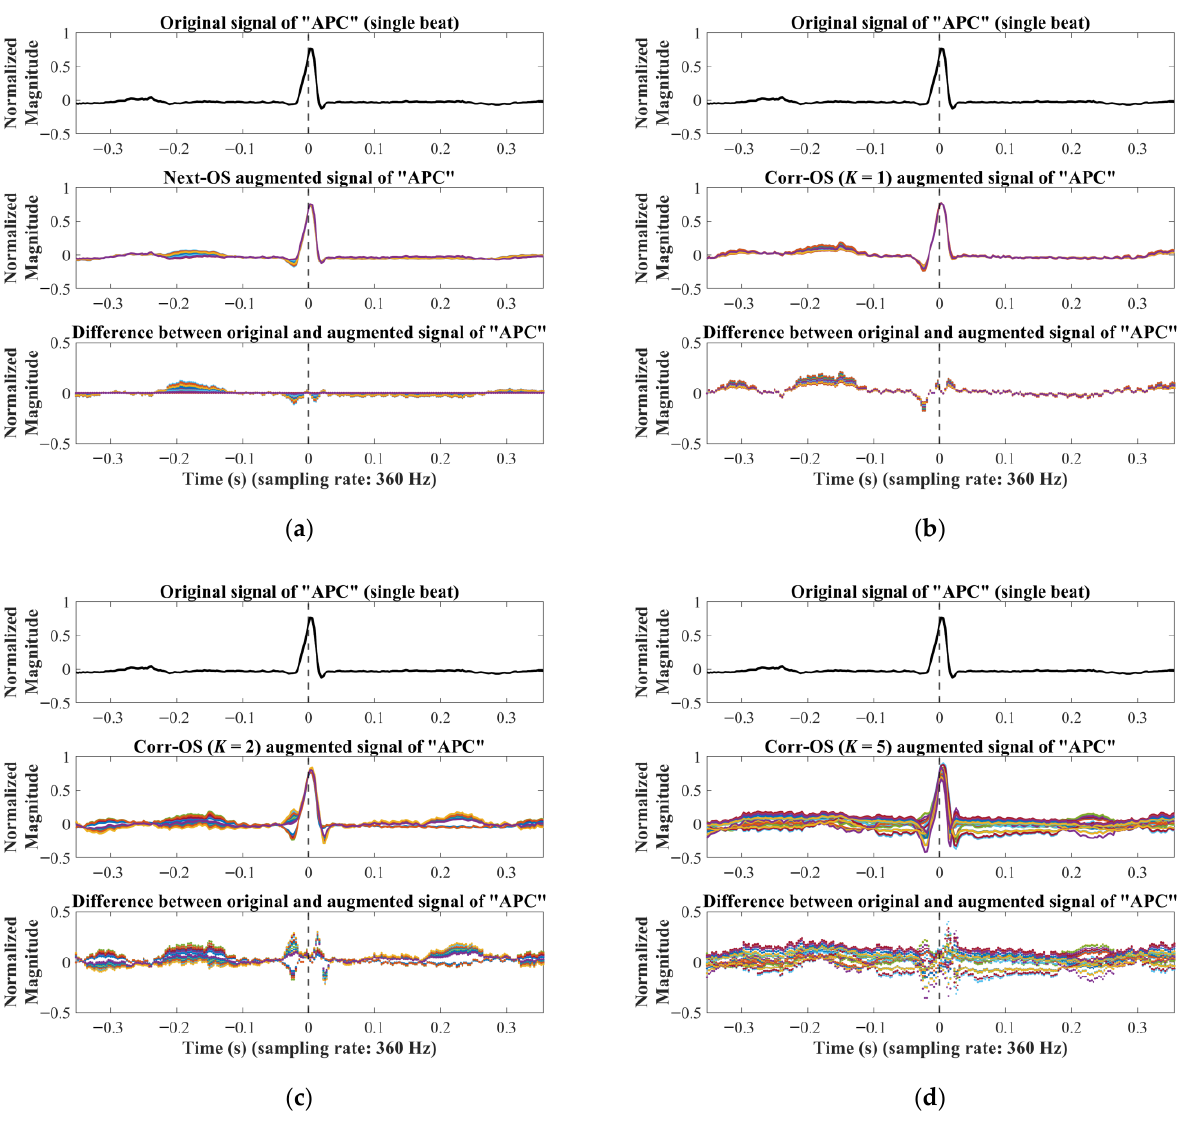
Figure 3. Differences between native and augmented ECG segments (symbol A, atrial premature beats) generated by the ( a ) Next-OS (next beat) and Corr-OS (top K correlation beats) algorithms with ( b ) K = 1, ( c ) K = 2, and ( d ) K = 5 (figure adapted from [59]).